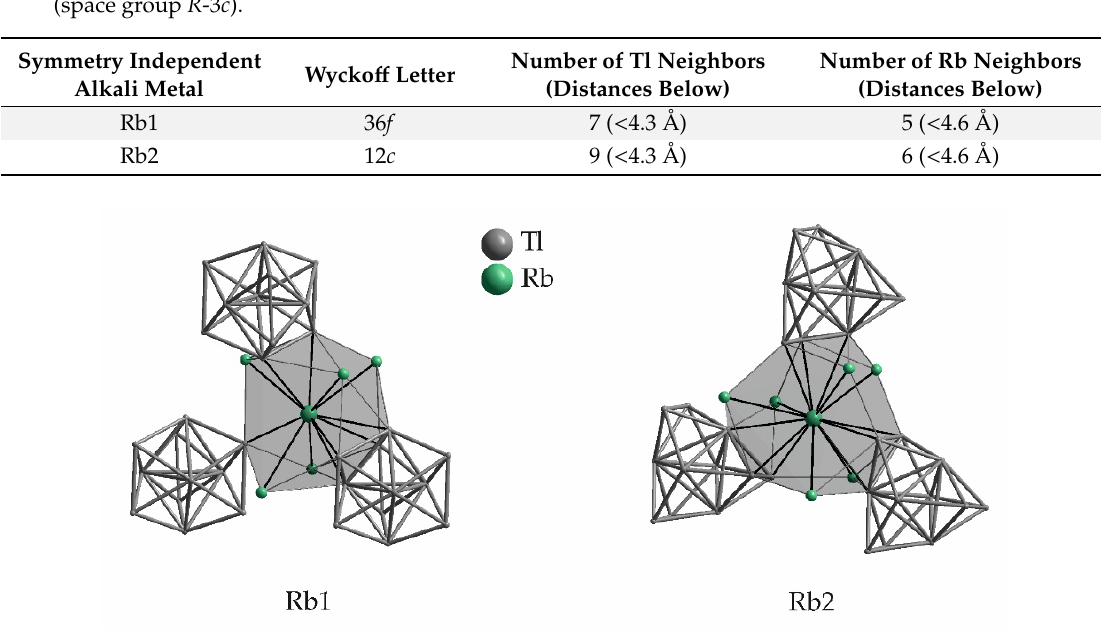
Table 5. Surrounding atoms of the symmetry inequivalent rubidium positions in Rb 8 Tl 11 (space group R -3 c ).